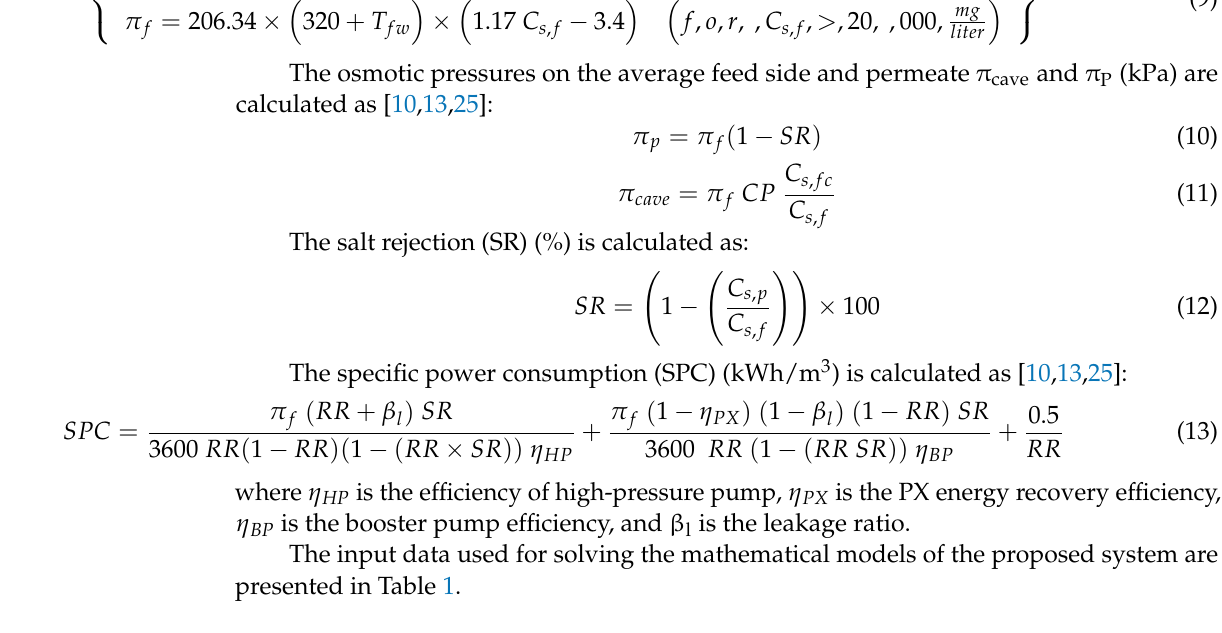
Table 1. Input data of proposed